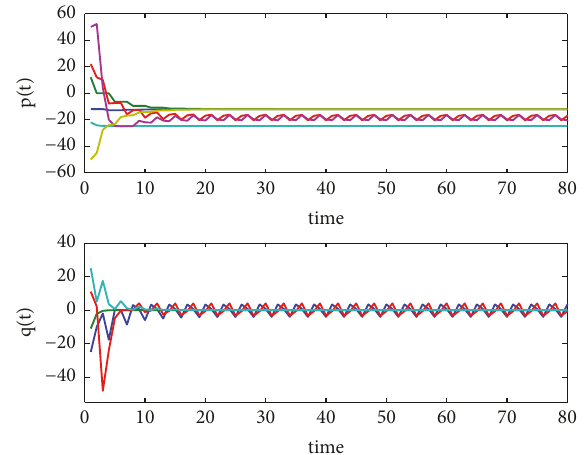
Figure 6: Agents’ state trajectories over networks switching among G G G 3 , 4 , and 6